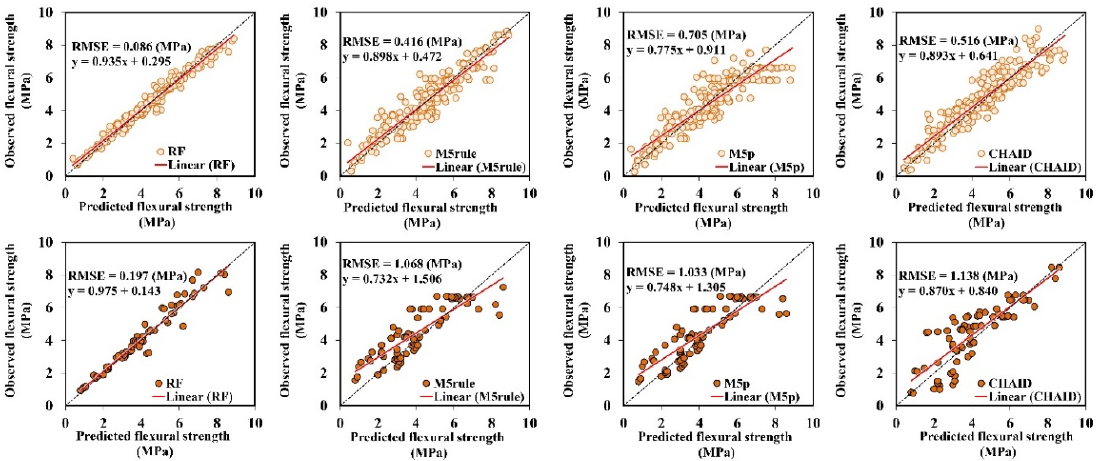
Figure 8. Scatter plots of the observed and simulated FS for training (light color) and testing (dark color) of the proposed models.